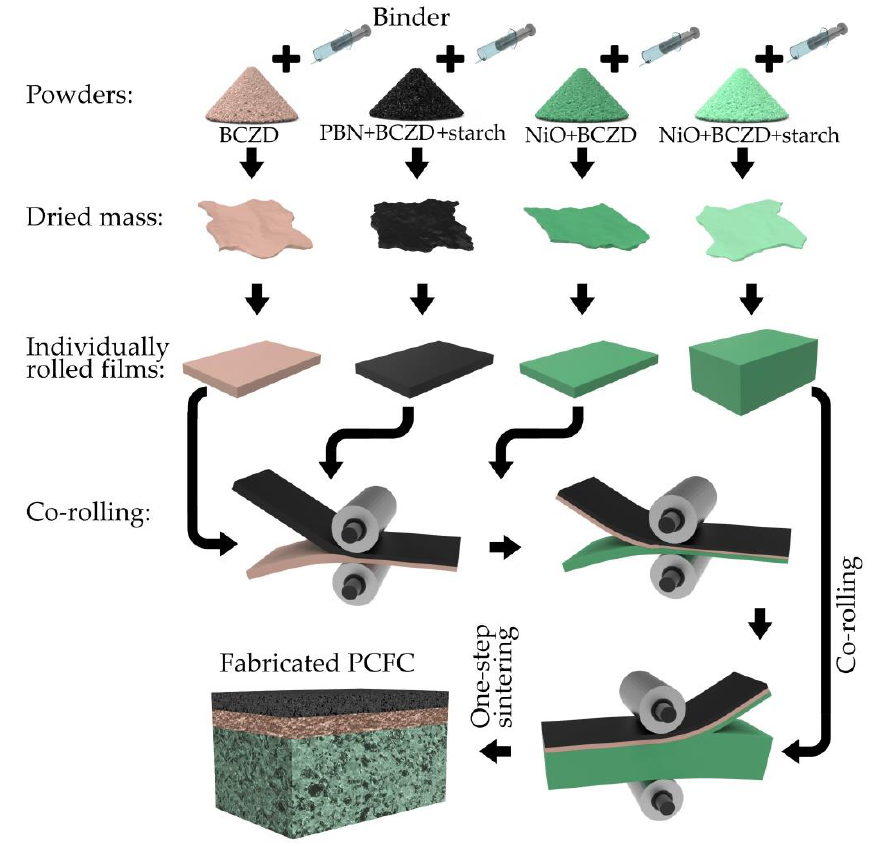
Figure 1. Principal scheme of protonic ceramic fuel cells (PCFCs) fabricated by tape calendering method and one-step sintering.